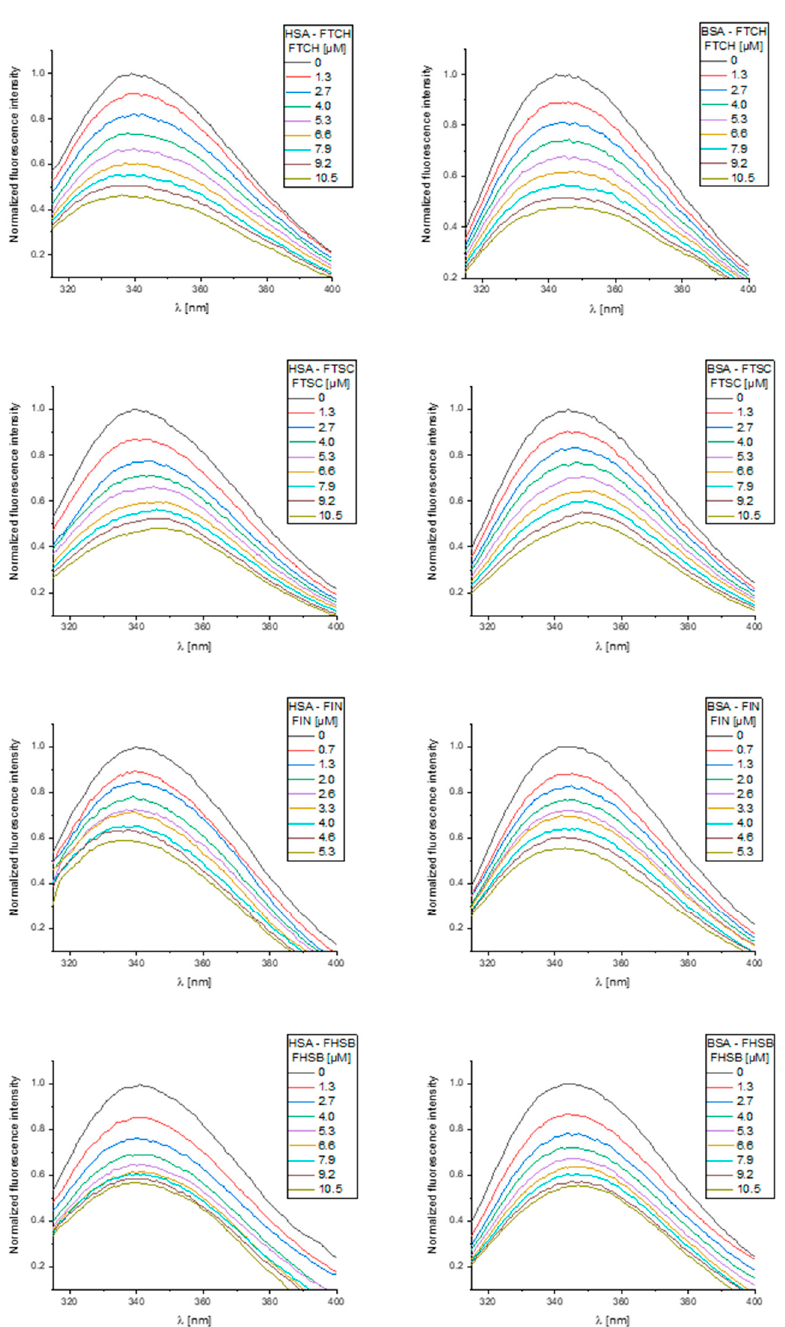
Figure 7. The normalized fluorescence emission spectra of human serum albumins (HSA) and bovine serum albumins (BSA) and their changes upon the increasing concentration of the ligands were studied.